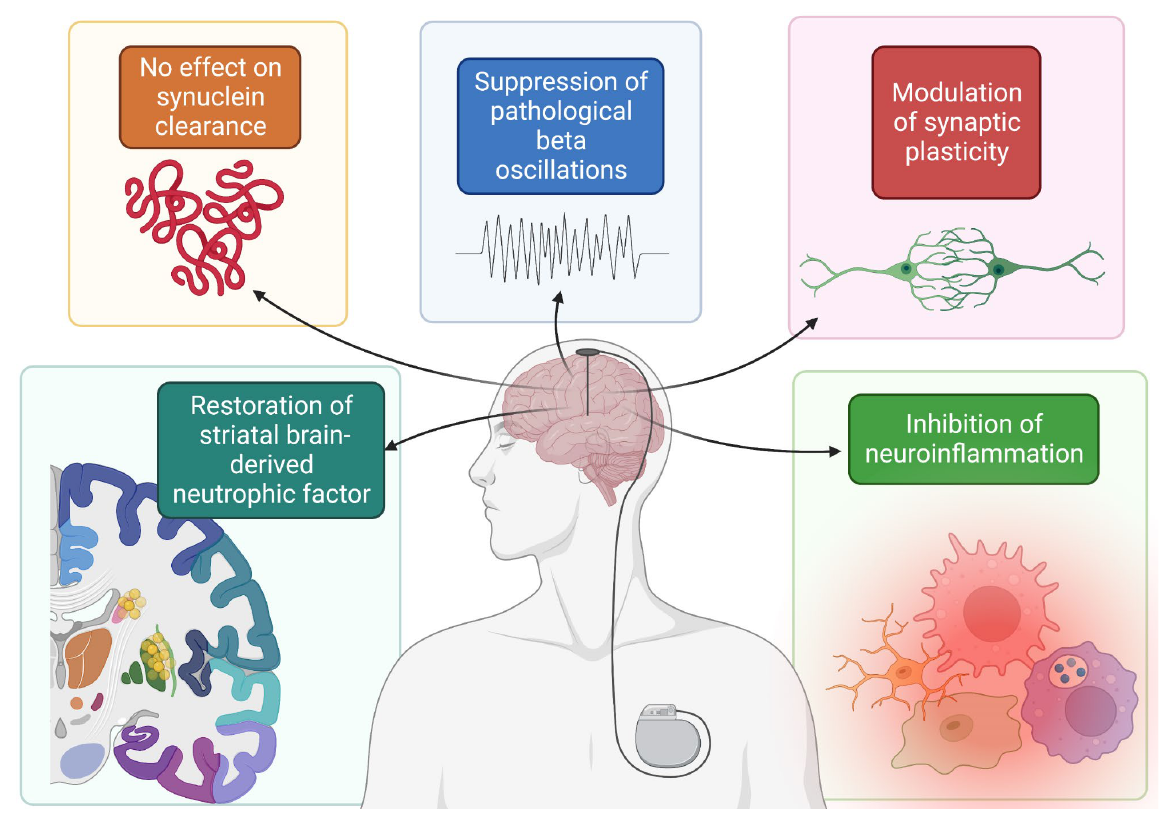
Figure 1. Summary of mechanisms by which DBS possibly confers a neuroprotective effect. Figure created with BioRender.com, accessed on 19 September 2022.